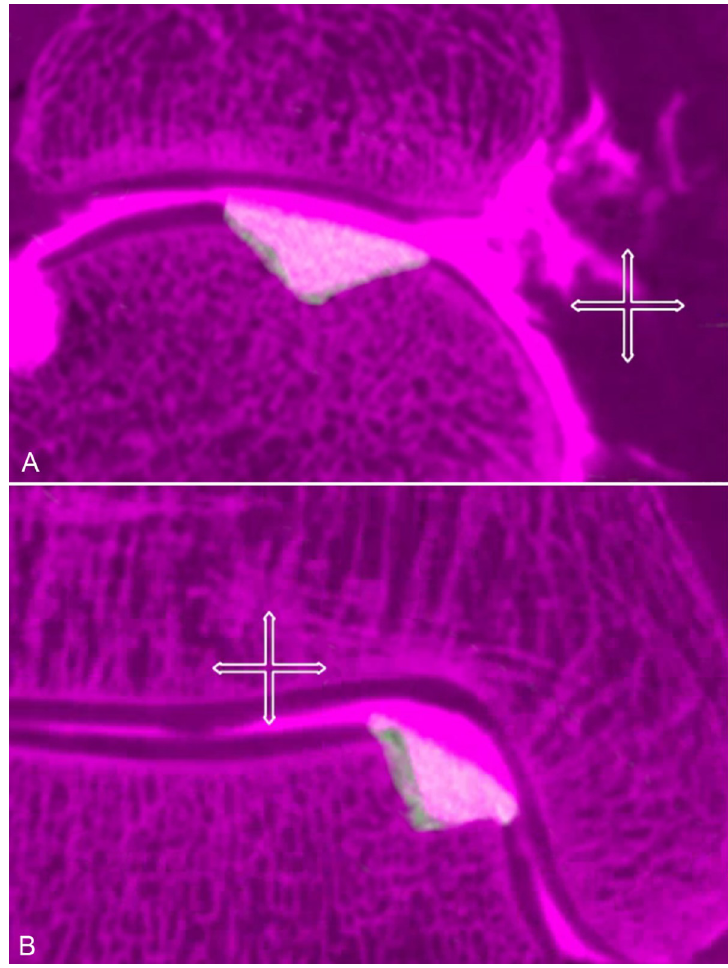
Fig 5. Fusion image of an osteochondral defect and the cast. Fusion mode images of an anteromedial defect in flat panel computed tomography arthrography (pink background) and the corresponding cast (brighter layer) in two different planes (A and B). Osteochondral defect and cast sizes can be directly compared. There is a visible overlay due to a slightly larger cast, explaining the mean differences of the measurements. The cross mark represents a 1 cm scale for both